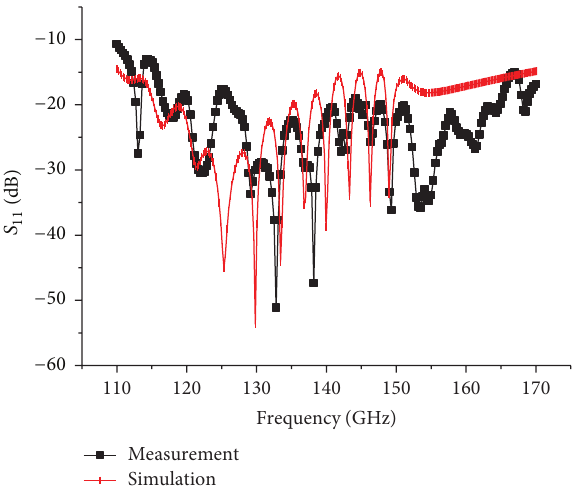
Figure 13: The simulation and measurement results of the antenna return loss.